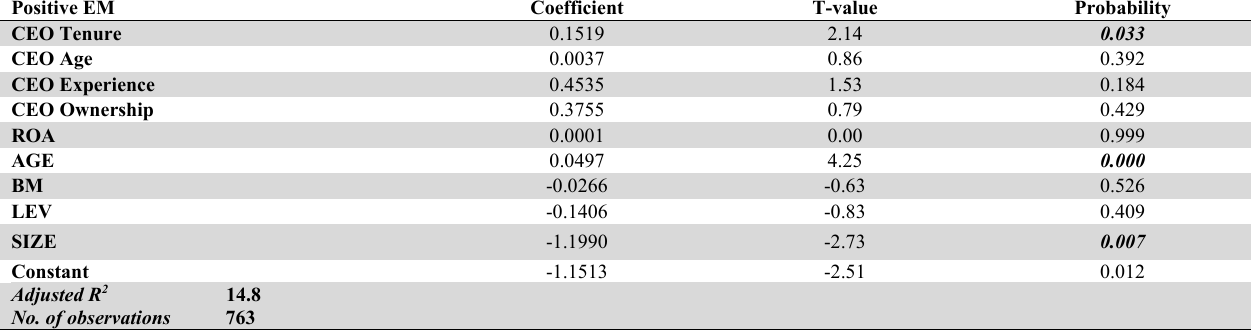
Regression results of the association between CEO characteristics and positive